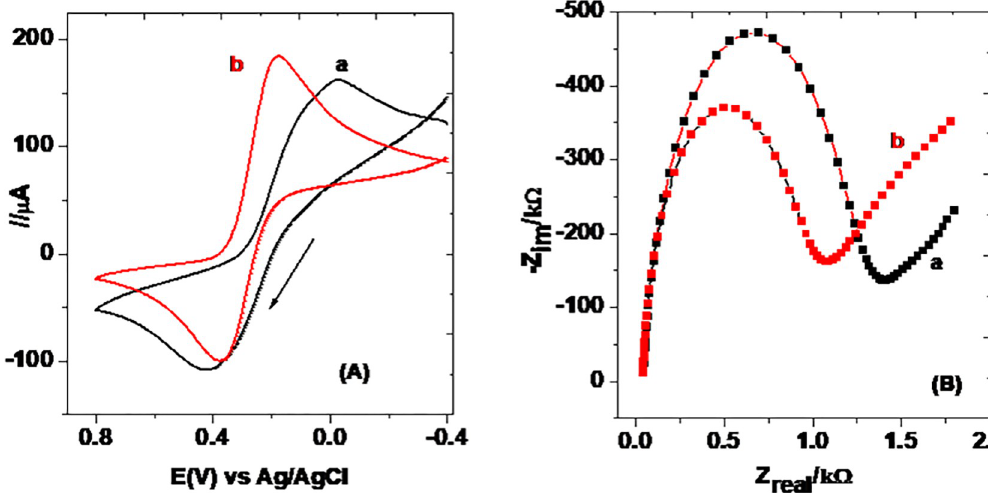
Fig 2. (A) cyclic voltammograms of 10.0 mM [Fe (CN) 6 ] 3-/4- mixture in pH 7.0 PBS containing 0.1 M KCl at (a) UCPE, and (b) MCPE, and (B) Nyquist plots of UCPE (a) and MCPE (b) in 10.0 mM [Fe (CN) 6 ] 3-/4- mixture in pH 7.0 PBS containing 0.1 M KCl at frequency range: 0.01–100,000 Hz, applied potential: +0.23 V, and amplitude: 0.01